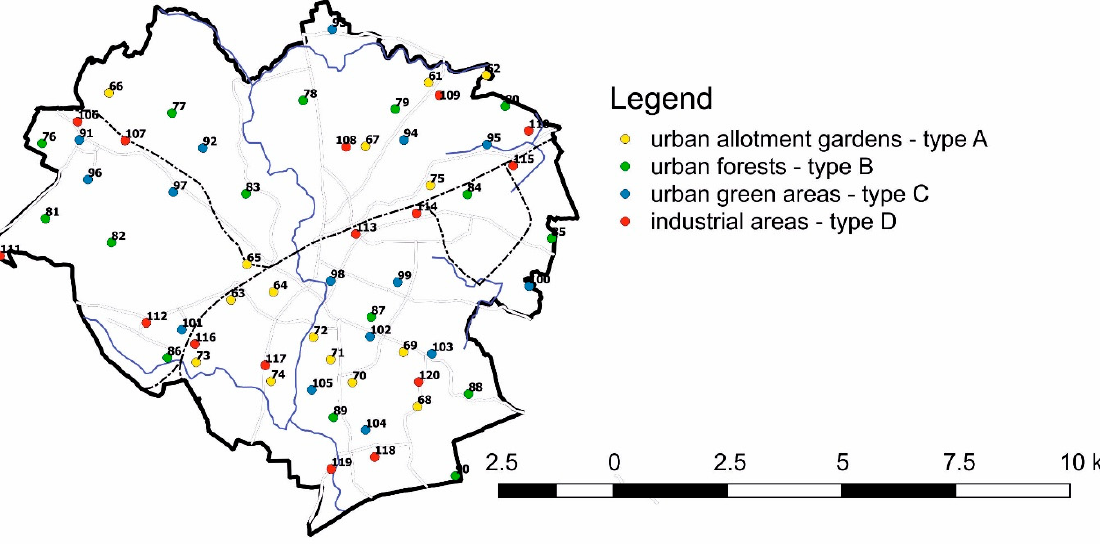
Figure 2. Location of soil and common dandelion sampling points in Olsztyn, including land-use types. Table 1. Cities selected for the study along with comparative analysis.